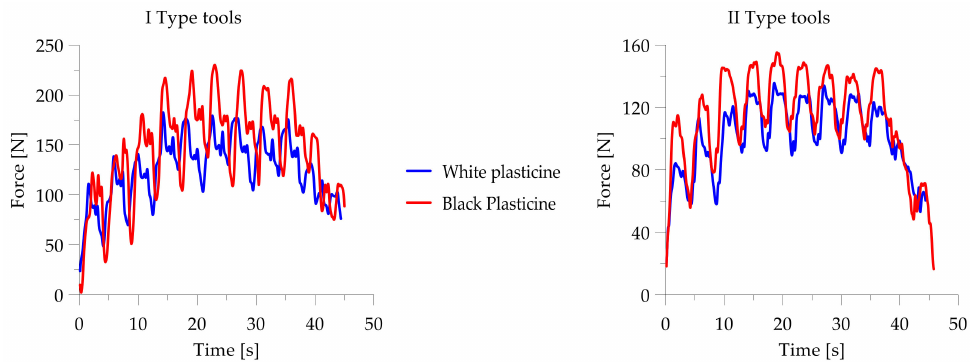
Figure 15. Diagrams of the change in the value of the expansion force during the ball skew rolling.